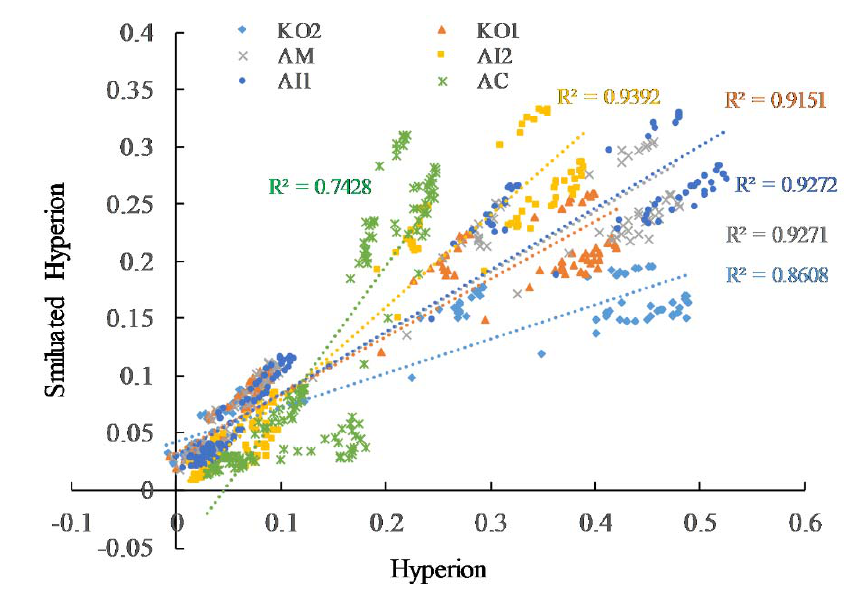
Figure 5. Correlation of reflectance from true Hyperion and Simulated Hyperion.